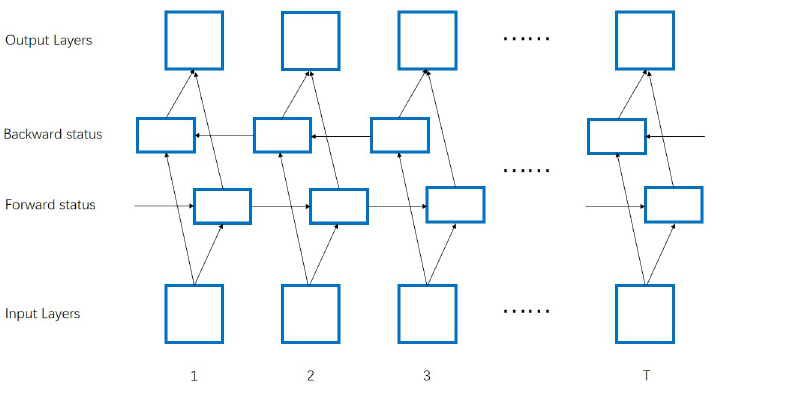
Fig 3. BGRU structure